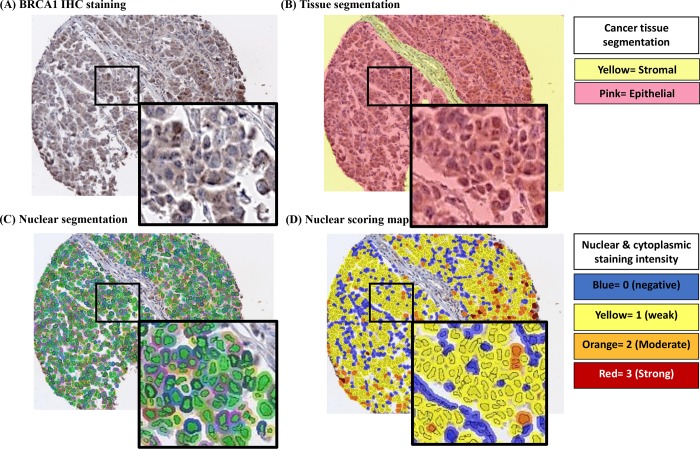
IHC staining and corresponding digital annotation for BRCA1 in a representative core.A: IHC staining utilizes MS110 mouse monoclonal antibody to assess the level of BRCA1 protein expression. B: Tissue segmentation where the epithelial compartment is pink and the stromal compartment is yellow. C: Nuclear segmentation. D: nuclear score map. Definition of the digital image annotation intensity score: blue = 0, yellow = 1, orange = 2 and red = 3. The attached legend to the right indicates what each color stands for in the tissue segmentation and score map.